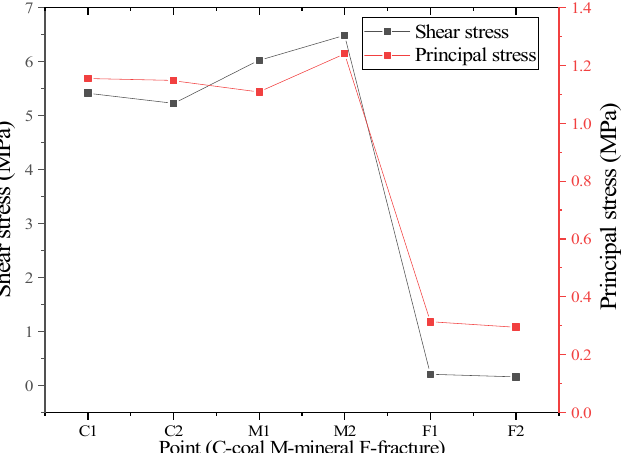
Figure 20. Shear stresses and principal stresses in different matrices (C—coal, M—mineral, and F— fracture).